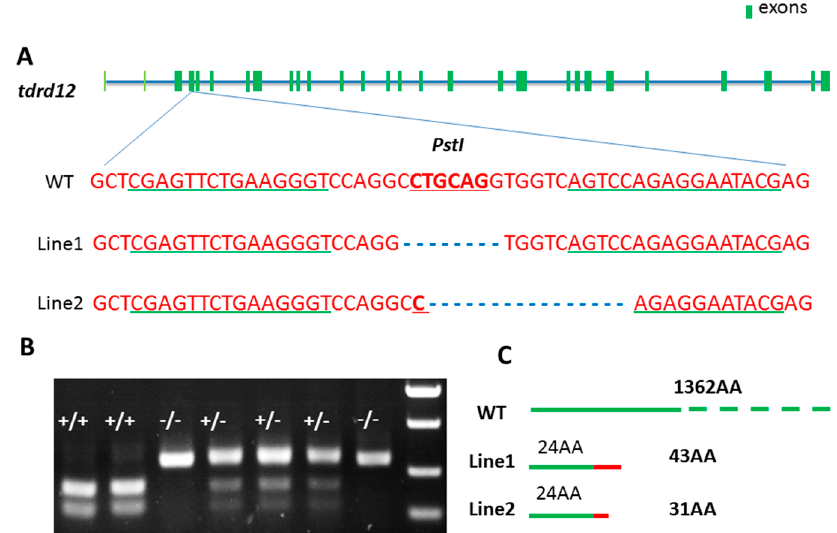
Figure 3. Generation of Tdrd12-deficient zebrafish by TALENs. ( A ) Binding site of engineered TALENS on the tdrd12 gene exon 2 (exons shown in dark green). The underlined-green fonts indicate the sequences of the two targeting arms of TALENS, and the red fonts show the restriction enzyme Pst1 cutting site. WT, wild-type. Mutant-line1 (M1) and mutant-line2 (M2) are two independent mutant lines in which the restrictive endonuclease site Pst1 is eliminated with 8 and 16 bp deleted, respectively. Mutation confirmation as shown by the sequencing results of the transcripts of the tdrd12 gene from the two mutant lines, M1 and M2; ( B ) Agarose gel electrophoresis image with the PCR products following Pst1 digestion of the tdrd12 locus of the F2 fish offspring. +/+, WT; +/ − , heterozygous; and − / − , homozygous; and ( C ) Diagram representative of wild-type (WT) and two putative truncated mutant Tdrd12 proteins, M1 and M2, in which the first 24 amino acids (shown in green boxes) are identical to those of the wild-type Tdrd12 protein and the following 19 and 7 amino acids in M1 and M2, respectively (shown in red boxes), are miscoded ones. Both putative mutant forms of Tdrd12 are terminated prematurely.